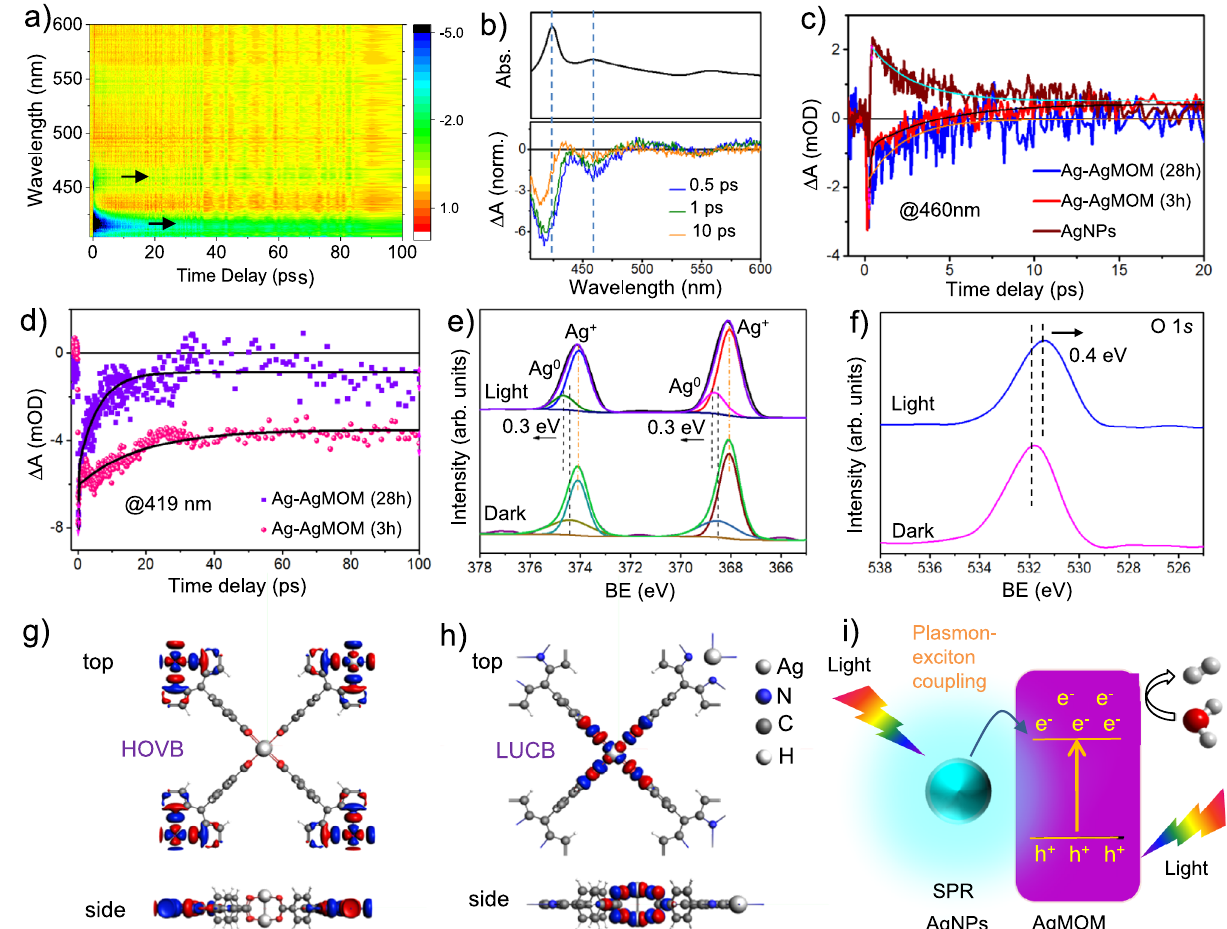
Fig. 5 | Photocatalytic mechanism studies of Ag – AgMOM photocatalyst. Fem- tosecond transient absorption spectrain a contour diagram a and atselected time delays b ofAg – AgMOM(3h)sample,obtainedwithapumpwavelengthof400nm. Thesteady-stateabsorptionspectrumisalsoshownatthetopin b forcomparison. c Transient time tracesatthe probewavelengthof460nmfor AgNPs, Ag – AgMOM (3h) and Ag – AgMOM (28h) samples. d Transient time traces at the strongest exciton wavelength of 419nm for both Ag – AgMOM (3h) and Ag – AgMOM (28h)